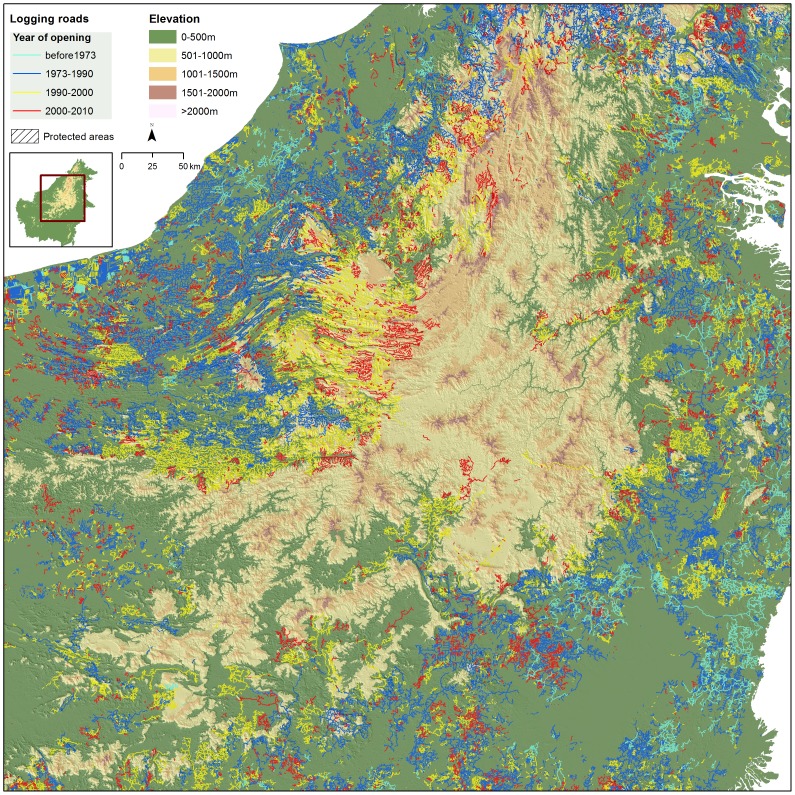
The heart of Borneo and the spatial progression of logging since 1973 depicting a logging ‘frontier’ moving steadily upward and inland, from the lowland coasts to the highlands.In many areas, logging roads are surrounding and abutting against the edges of highland protected forests – the last contiguous bastions of intact forest.